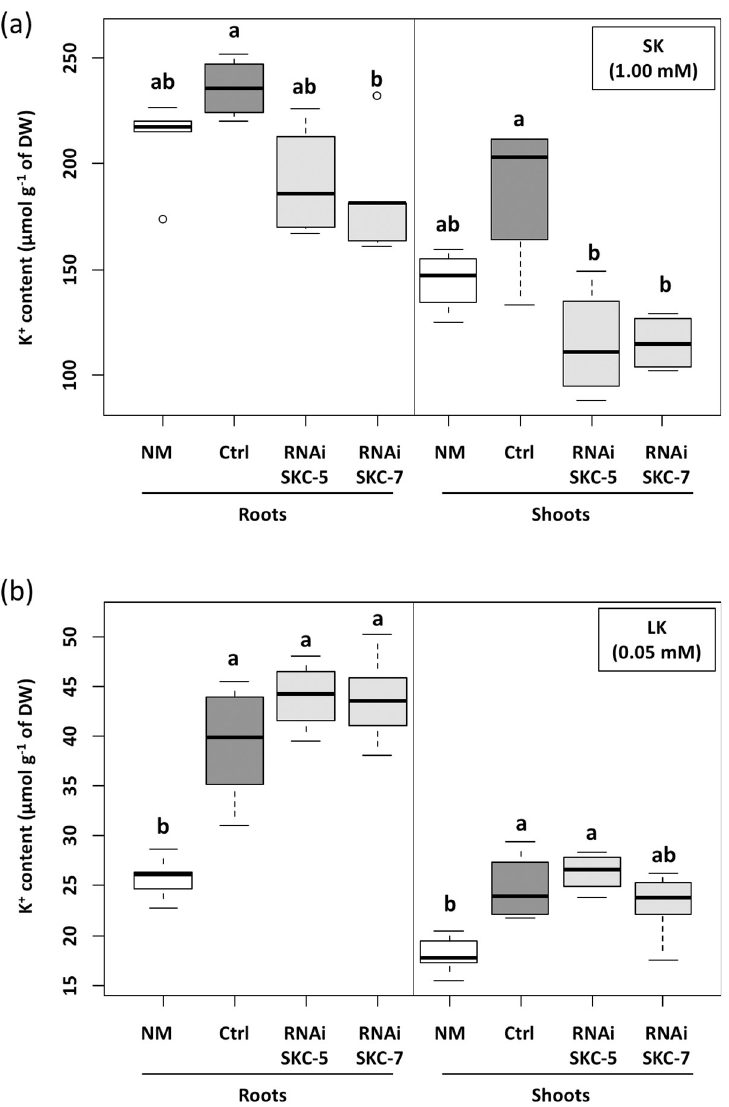
Fig 6. Potassium content in 2-month-old Pinus pinaster plants growing alone or in co-culture with Hebeloma cylindrosporum under K + -sufficient or -deficient conditions. Root and shoot contents were measured in non- mycorrhizal plants (NM) and plants inoculated with fungi transformed with the empty (Ctrl) or HcSKC -silencing vectors (RNAi-SKC-5 and RNAi-SKC-7), and growing at standard K + (SK medium, 1 mM K + , a) or low K + (LK medium, 0.05 mM K + , b). Mean values are provided with the standard error (n = 5–6). Different letters indicate significant differences between treatments according to one-way ANOVA followed by Tukey HSD post-hoc tests (P < 0.05).